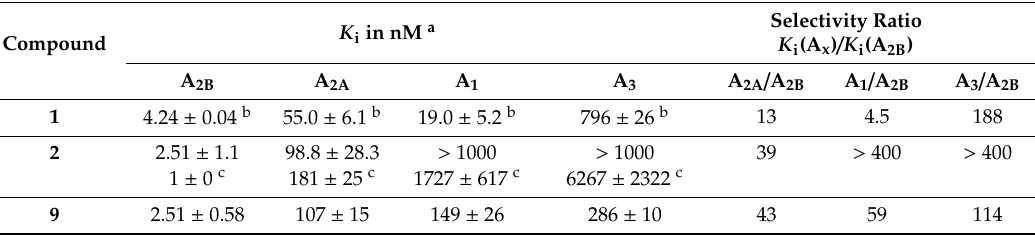
Table 1. K i values of 1 , lead compound 2 , and the new fluorinated derivative 9 at the four human adenosine receptor subtypes along with the corresponding selectivity